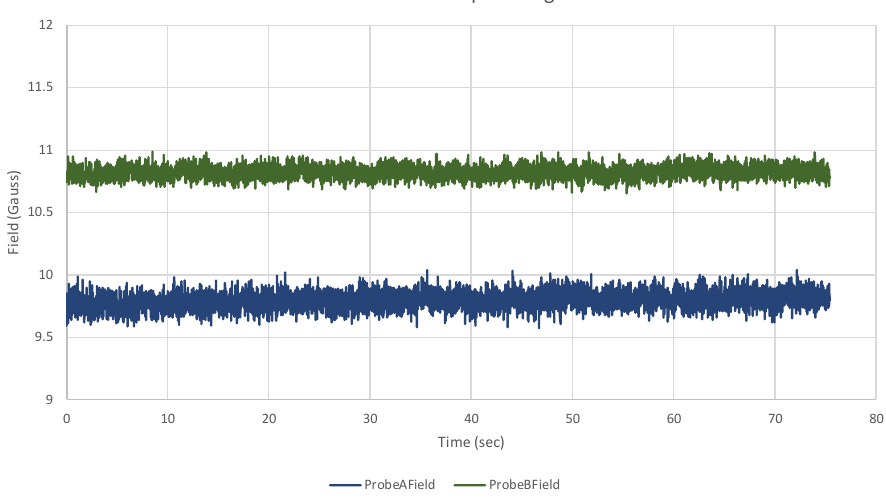
Figure 7. The test result of Hall probe system.